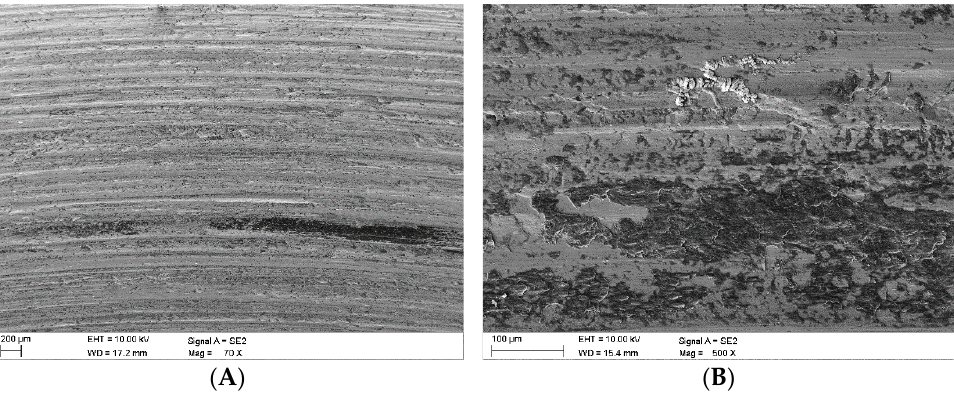
Figure 12. Images of the surface of the steel samples worn in the presence of the Claystone_1 abrasive; ( A )—scaly surface cracks, ( B )—microscratches filled with fragmented claystone grains.